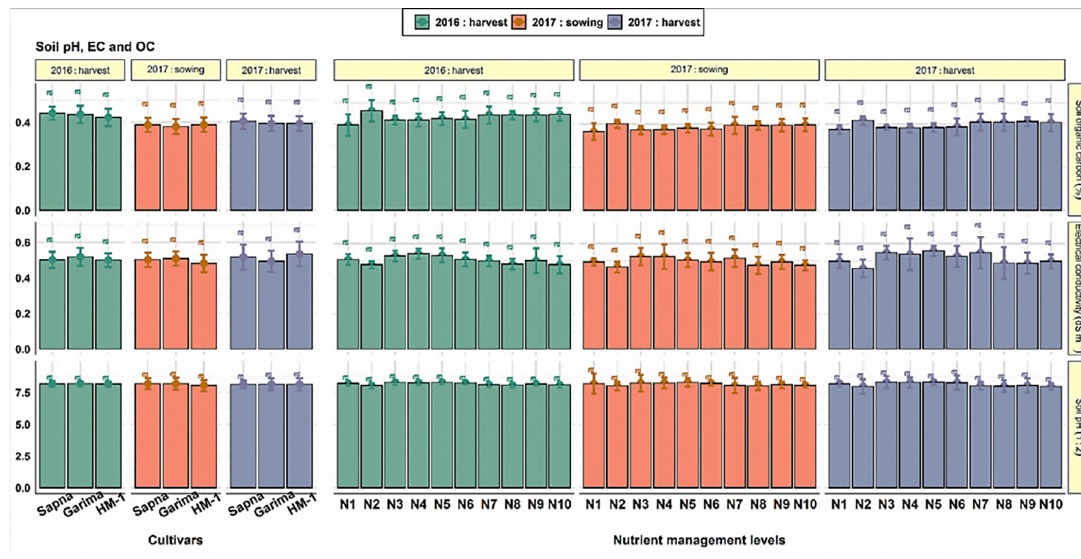
Fig 5. Soil pH, EC and organic carbon as influenced by cultivar selection and nutrient management